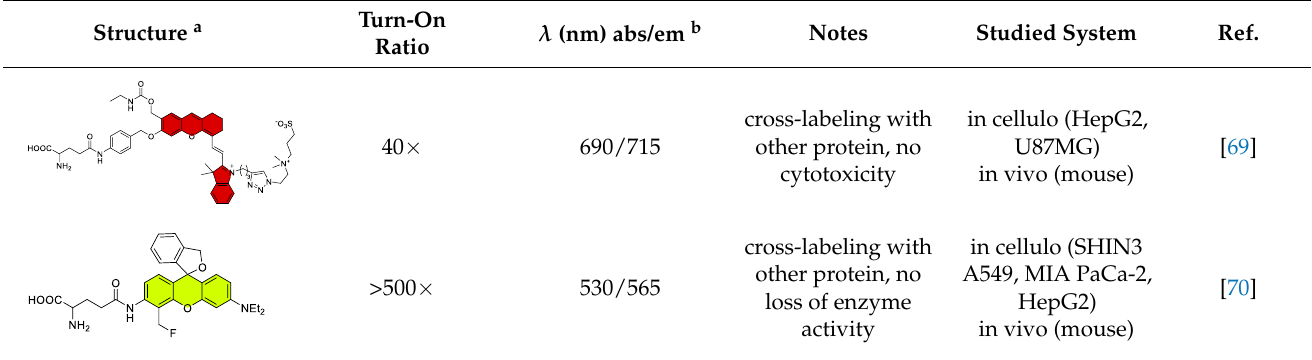
Table 7. Activity-based probes for γ -glutamyl-transpeptidase. Structure a